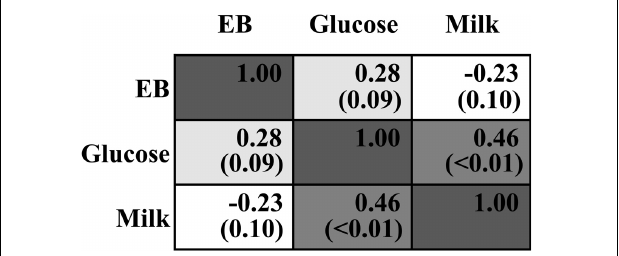
FIGURE 1 | Correlation analysis between infused glucose level (Glucose), energy balance (EB), and milk production (Milk). The upper number within each cell means Pearson Correlation Coefficient. The lower number with the bracket means P